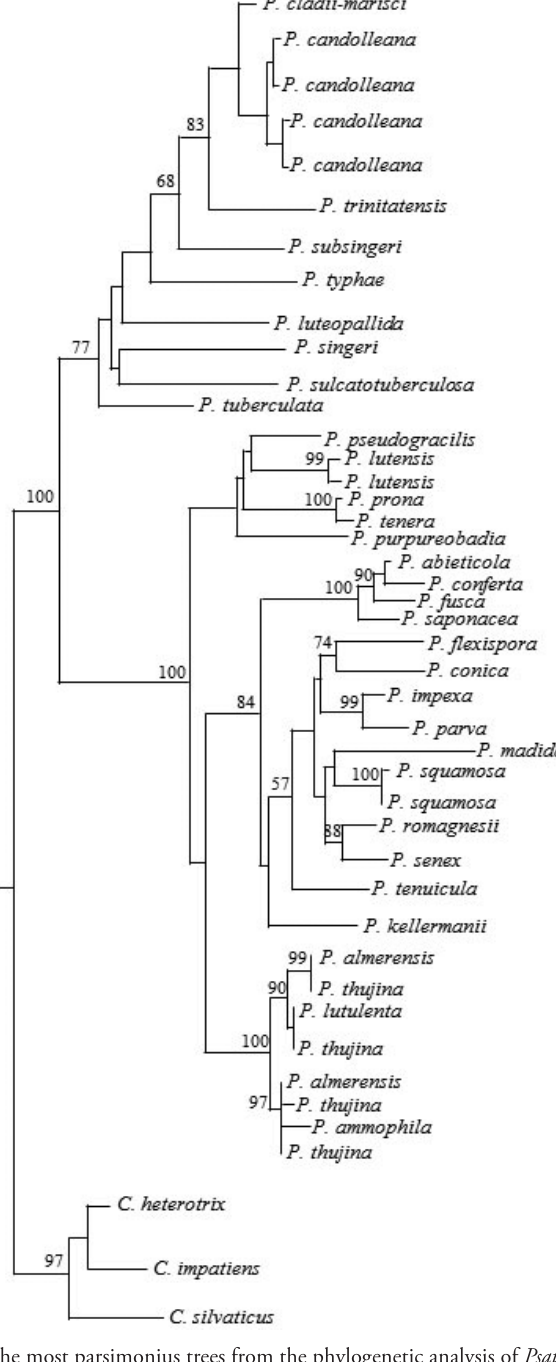
Figure 4. One of the most parsimonius trees from the phylogenetic analysis of Psathyrella spp. based on nrDNA sequence data. Bootstrap values are shown above branches based on 1,000 replicates (values below 50 are not